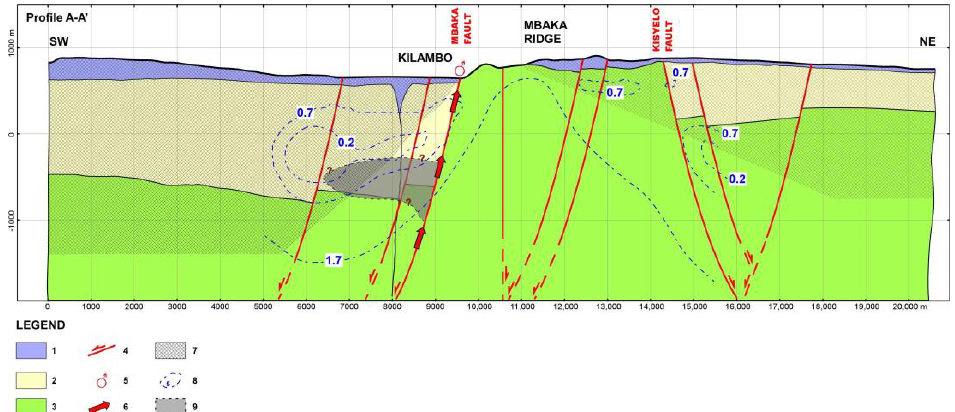
Figure 7. Conceptual model of the Kilambo-Ilwalilo geothermal play along the cross-section A- A’ (Figure 6). (1) Neogene – Recent volcanics; (2) sedimentary cover; (3) metamorphic basement; (4) (Figure 6). (1) Neogene–Recent volcanics; (2) sedimentary cover; (3) metamorphic basement; (4) main main fault; (5) hot spring; (6) hydrothermal flow; (7) low-density layers as inferred from gravity fault; (5) hot spring; (6) hydrothermal flow; (7) low-density layers as inferred from gravity modelling; modelling; (8) i soresistivity lines (labels are the logarithm of the resistivity value, in Ω m); (9) (8) isoresistivity lines (labels are the logarithm of the resistivity value, in Ω m); (9) geothermal geothermal reservoir.